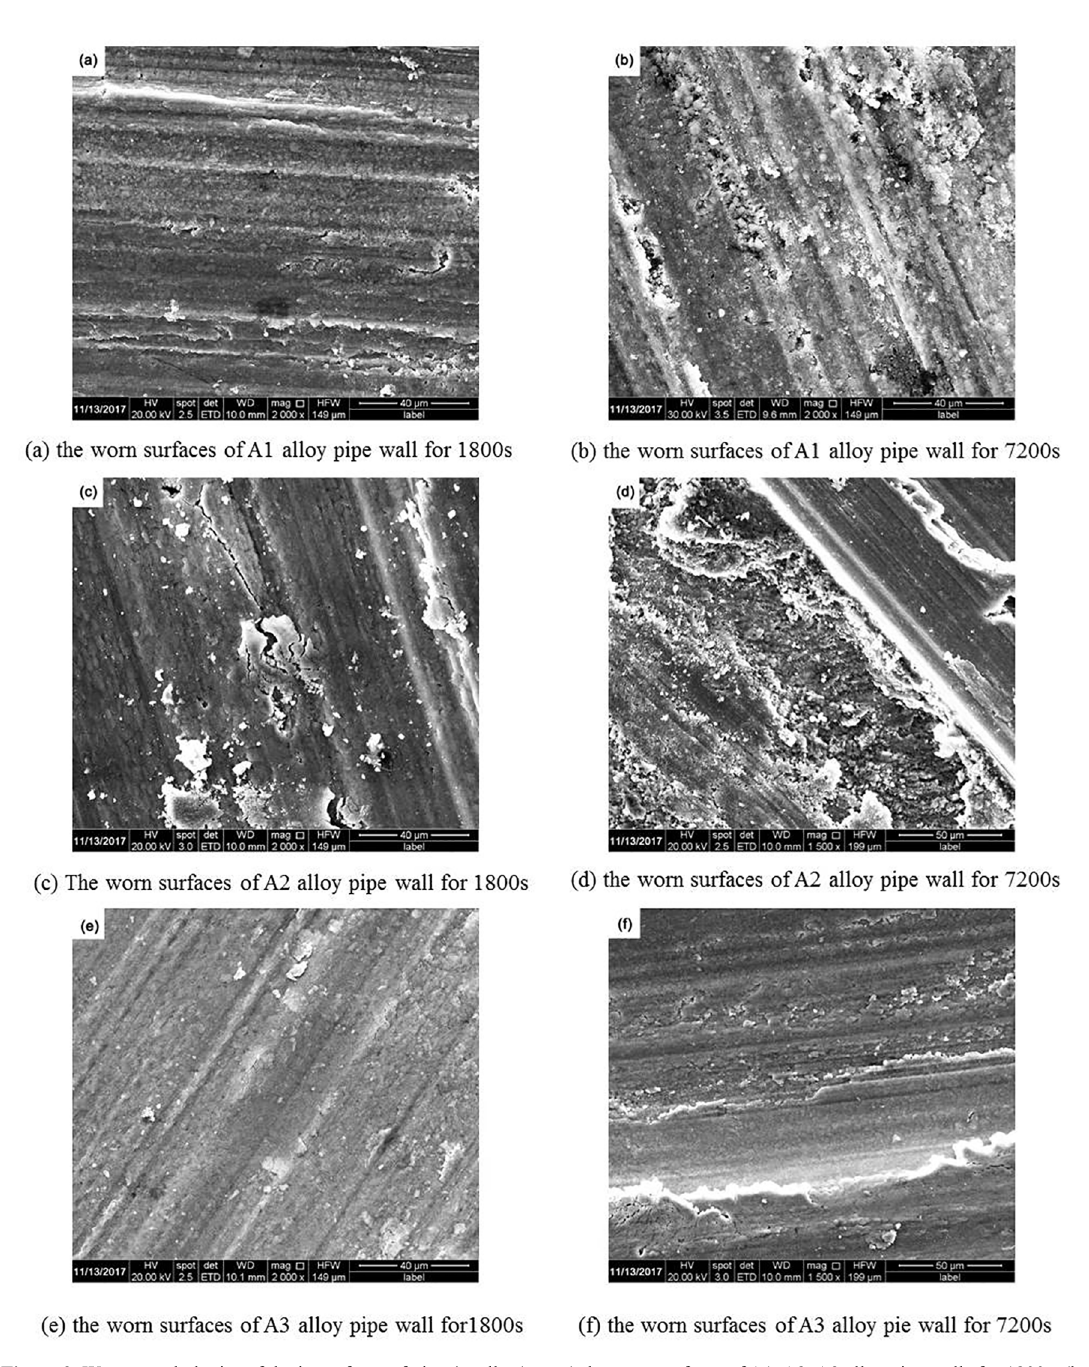
Figure 9. Worn morphologies of the inner faces of pipes’ walls: (a, c, e) the worn surfaces of A1, A2, A3 alloy pipe walls for 1800s; (b, d, f) the worn surfaces of A1, A2, A3 alloy pipe walls for 7200s. Table 2. Wear test data of the inner face of the A1, A2 and A3 alloy pipes Load and wear